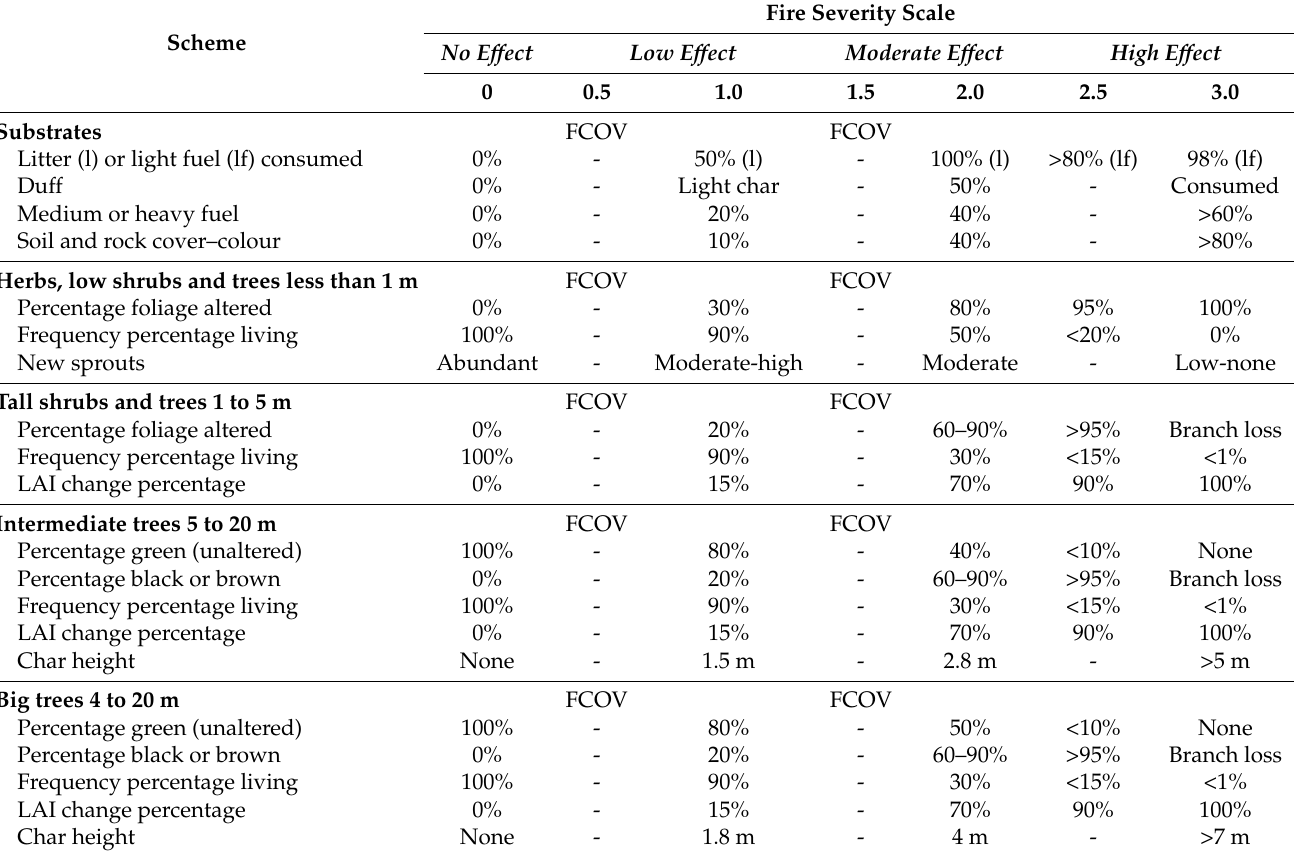
Table 2. The Geometrically structured Composite Burn Index (GeoCBI) criteria used to estimate the field fire severity